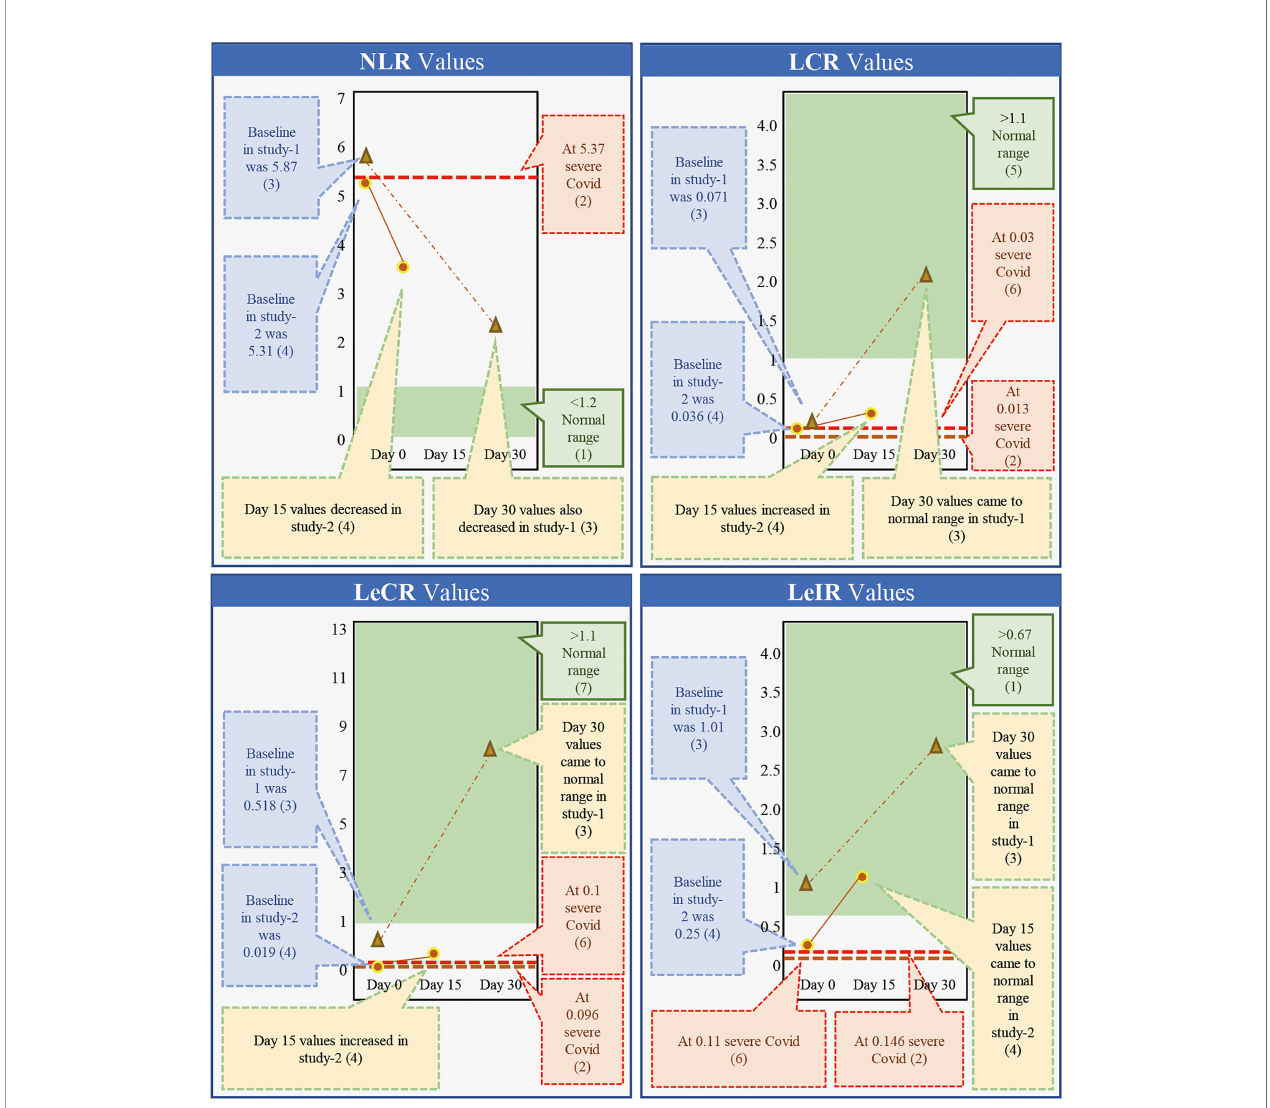
FIGURE 2 | Comparison of markers of immunity (NLR, LCR, LecR, and LeIR) associated with severe COVID-19 with high a risk of mortality from the literature against the outcome of studies done on consumption of Aureobasidium pullulans strain (AFO-202 and N-163)-produced b -glucans in COVID-19 patients demonstrating that the marker levels were regulated to normal range after 15 days of consumption and the values remained in the normal range post-30 days as well [(1) Ref. no (66).; (2) Ref. no (55).; (3) Ref. no (41).; (4) Ref. no (42).; (5) Ref. no (63).; (6) Ref. no (55).; (7) Ref. no